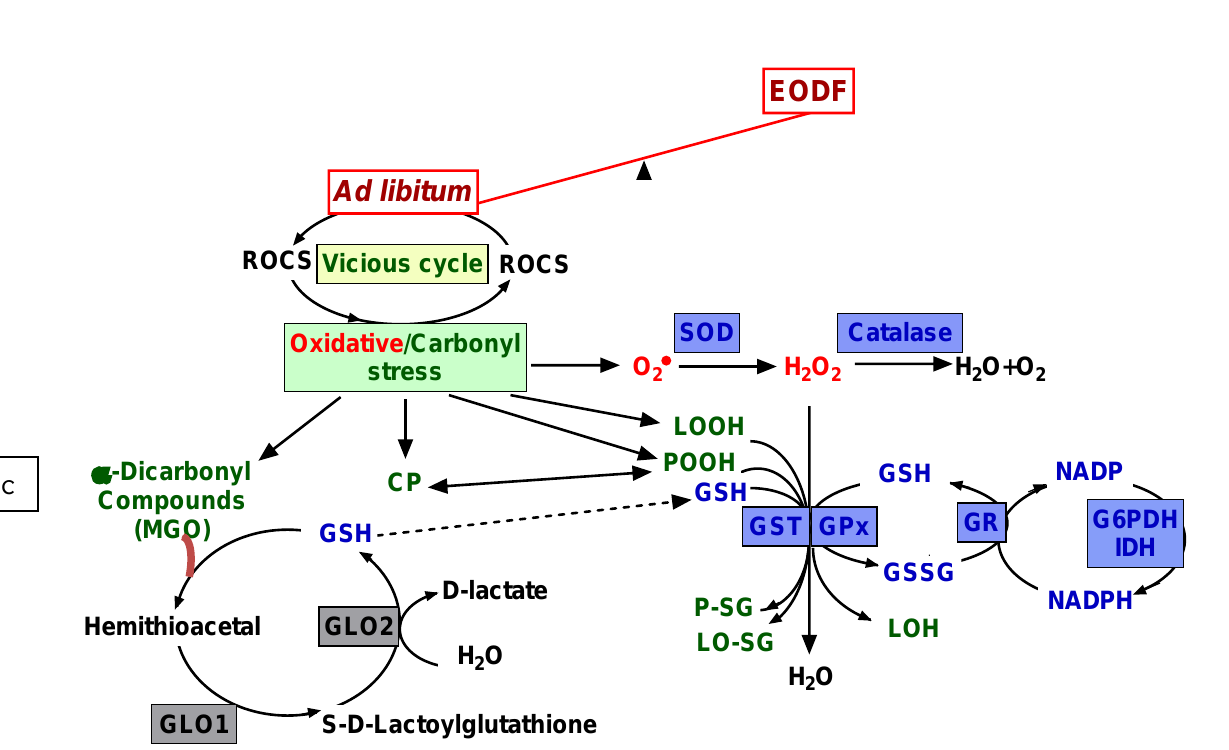
Figure 1: Relationship between feeding regimen, ROCS production, and protective mechanisms. Reactive oxygen (ROS) and carbonyl species (RCS) are constantly produced as byproducts of non- enzymatic oxidation/glycation and can interact with virtually all cellular components leading to develop- ment of oxidative/carbonyl stress. Lipid peroxides (LOOH), protein peroxides (POOH) and α-dicarbonyl compounds (MGO – methylglyoxal) are reactive intermediate products and carbonyl proteins (CP) are the end products of glycoxidation, and, therefore, they are the hallmarks of oxidative/carbonyl stress. Under normal conditions, a balance between ROCS generation and elimination is maintained by com- plex antioxidant/antiglycation defensive systems. Feeding to satiation leads to an increase in ROCS production followed by chronic oxidative/carbonyl stress with intensification of the modification of bio- molecules. Every-other-day fasting (EODF) regimen alleviates the intensity of oxidative/carbonyl stress preventing biomolecule damages. Denotations of defensive enzymes: GLO1 and GLO2 – glyoxalase 1 and 2, SOD – superoxide dismutase, GST – glutathione-S-transferase, GR – glutathione